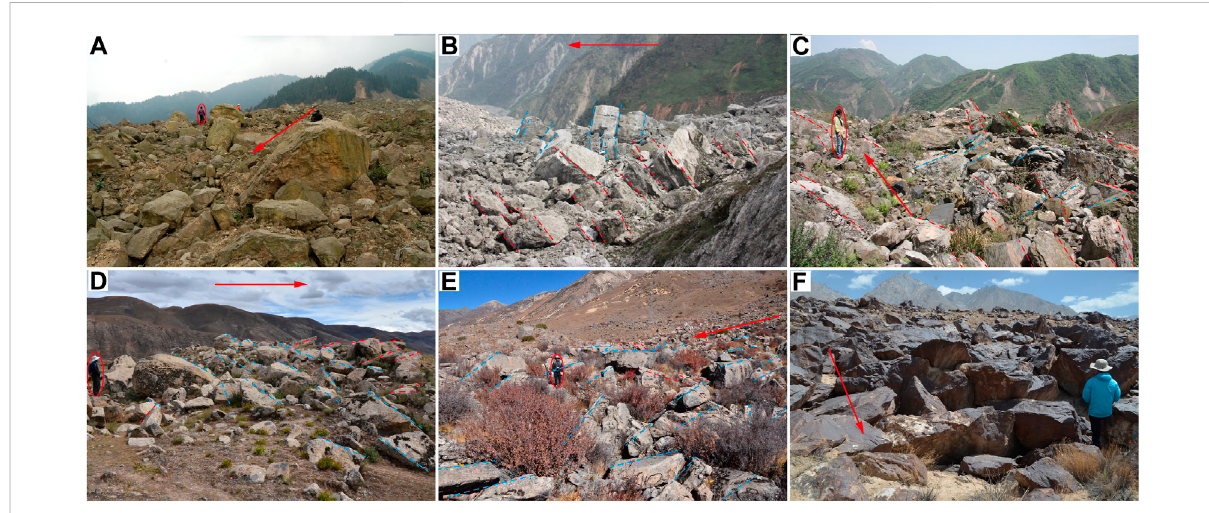
FIGURE 4 Clast-supportedstructures composed ofblocks inthecarapacefaciesoftheXiejiadianzi (A) , Daguangbao (B) ,Donghekou (C) ,Nyixoi Chongco (D) , Luanshibao (E) , and Tagarma (F) rock avalanches. The red arrow in each sub fi gure indicates the main movement direction of the avalanche masses with these dashed lines marking the preferred inclinations of fragmented